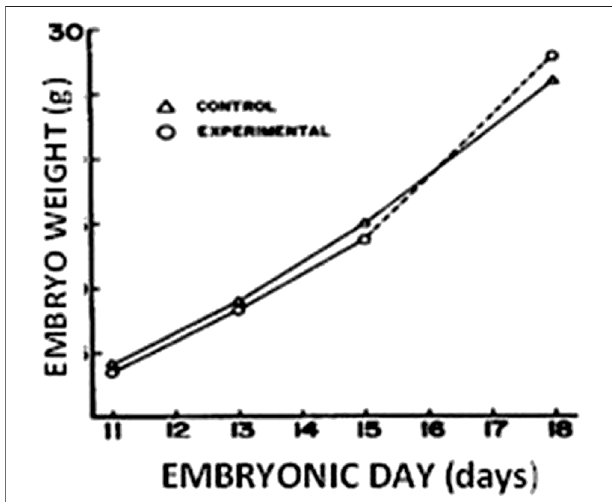
FIGURE 1 | Chicken embryo weight (g) according to hyperoxia treatment (60% O 2 on d 16 – d 18) [adapted from Stock and Metcalfe